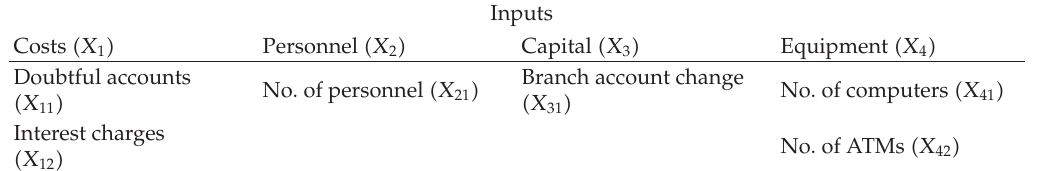
Table 1: List of model inputs and outputs.